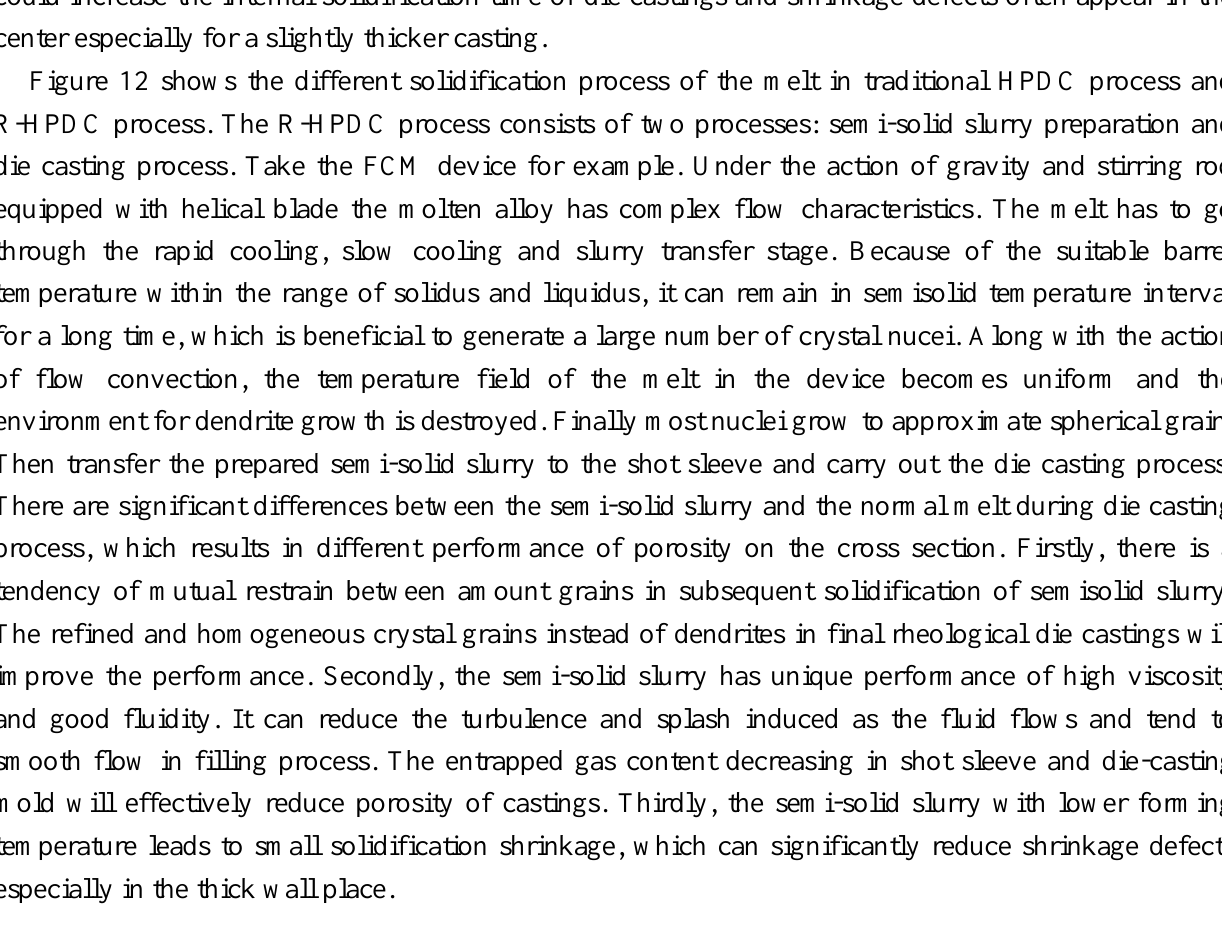
Figure 12. Solidification process of the melt in traditional HPDC process and R-HPDC